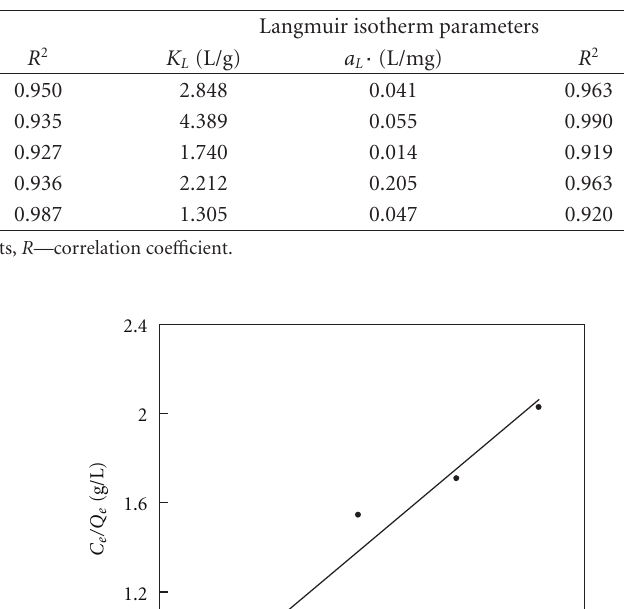
Table 2: Freundlich and Langmuir parameters for the adsorption of phenol.